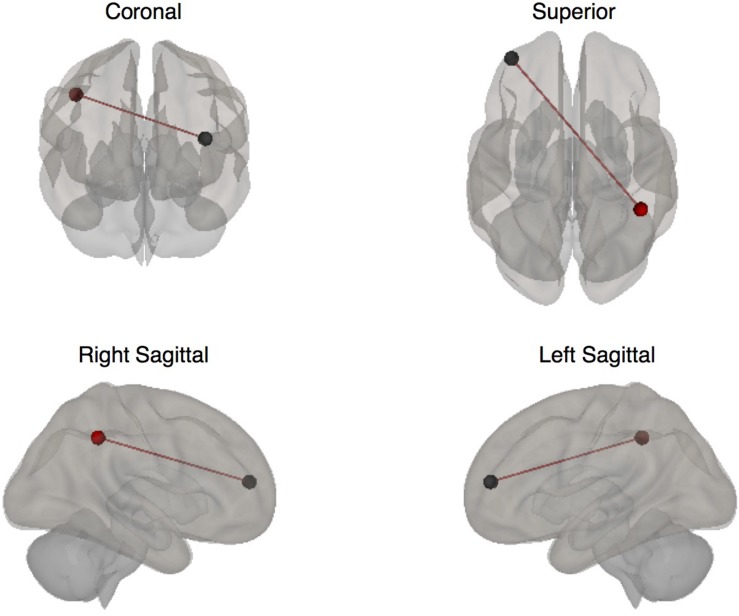
Seed to target ROIs with significantly increased connectivity during the 2-Back task at post-intervention (ROI colors: Red = left DLPFC; Black = right IPL).